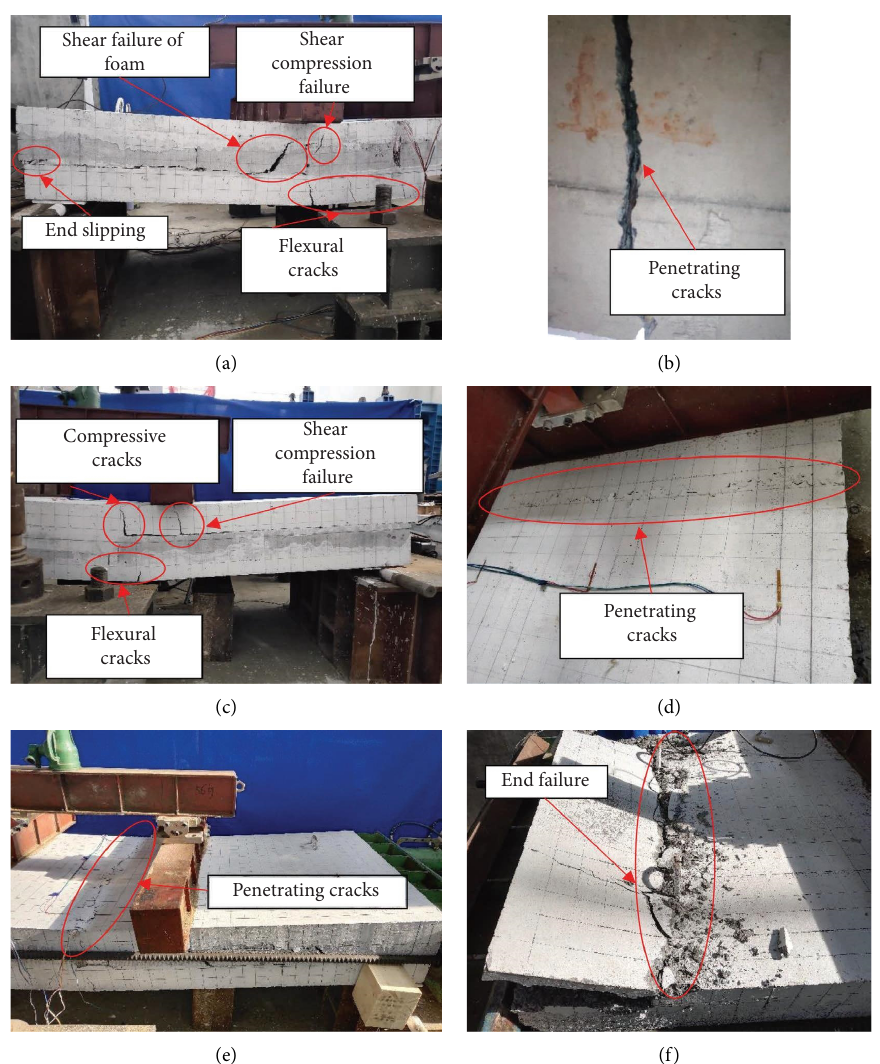
Figure 6: Failure modes of tested Sandwich wall panels. (a) Side view of specimen G24-I, (b) back of bottom wythe of specimen G24-I, (c) side view of specimen G24-II, and (d) vertical view of top wythe of specimen G24-I, (e) specimen G24A0.2-I, and (f) specimen